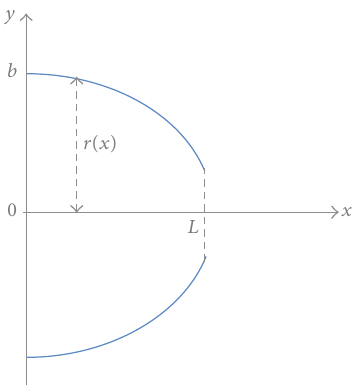
Figure 3: Region used to set the limits for integration in this work. The boundary conditions required to solve (6) are explained in